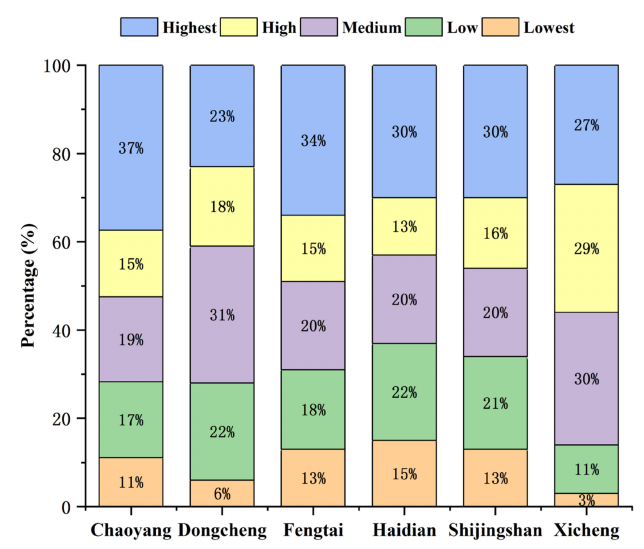
Figure 13. The proportion of the population with different UGI levels in six districts.